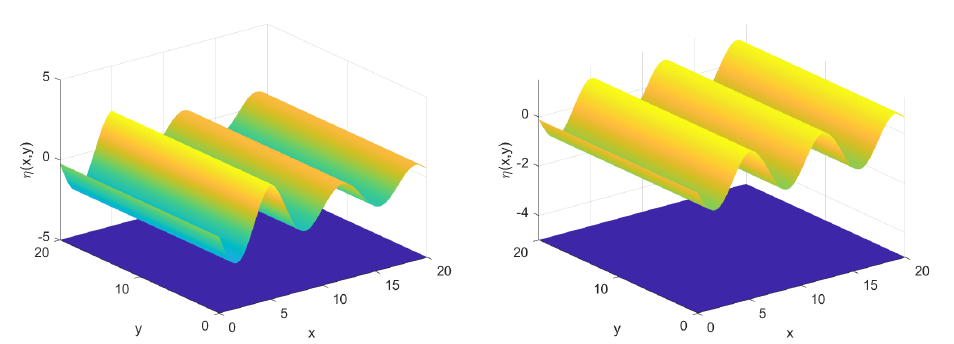
Figure 11. 2-D Numerical Simulation of The Wave Propagation Phenomenon in a Flat Bottom-Profile with ( left ) Friction-Coefficient, c f = 0.32 ( right ) Diffusion-Coefficient, c D =